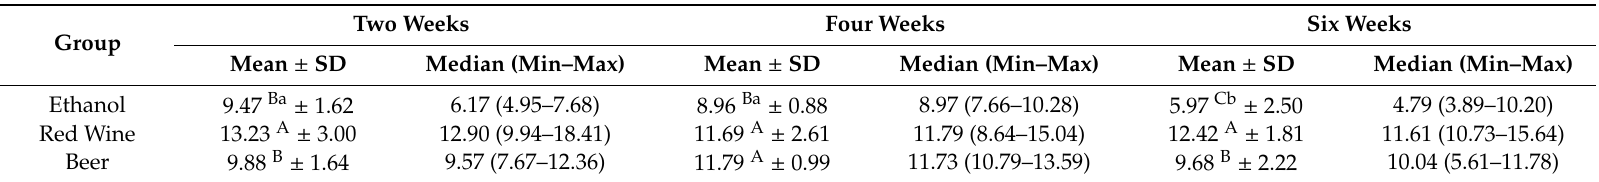
Table 4. Daily alcoholic beverage intake (kcal / day) in the groups of experimental rats stratified by a group and experiment